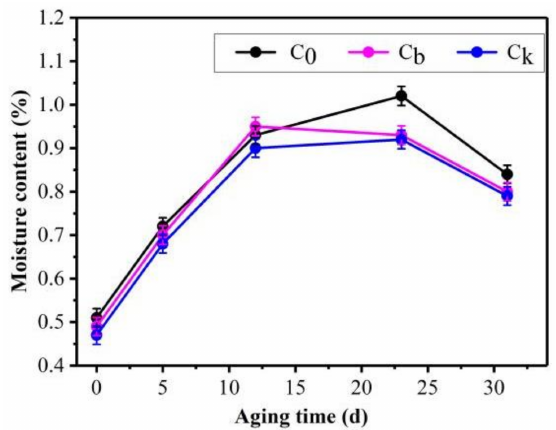
Figure 2. Moisture content of insulation papers with different degrees of